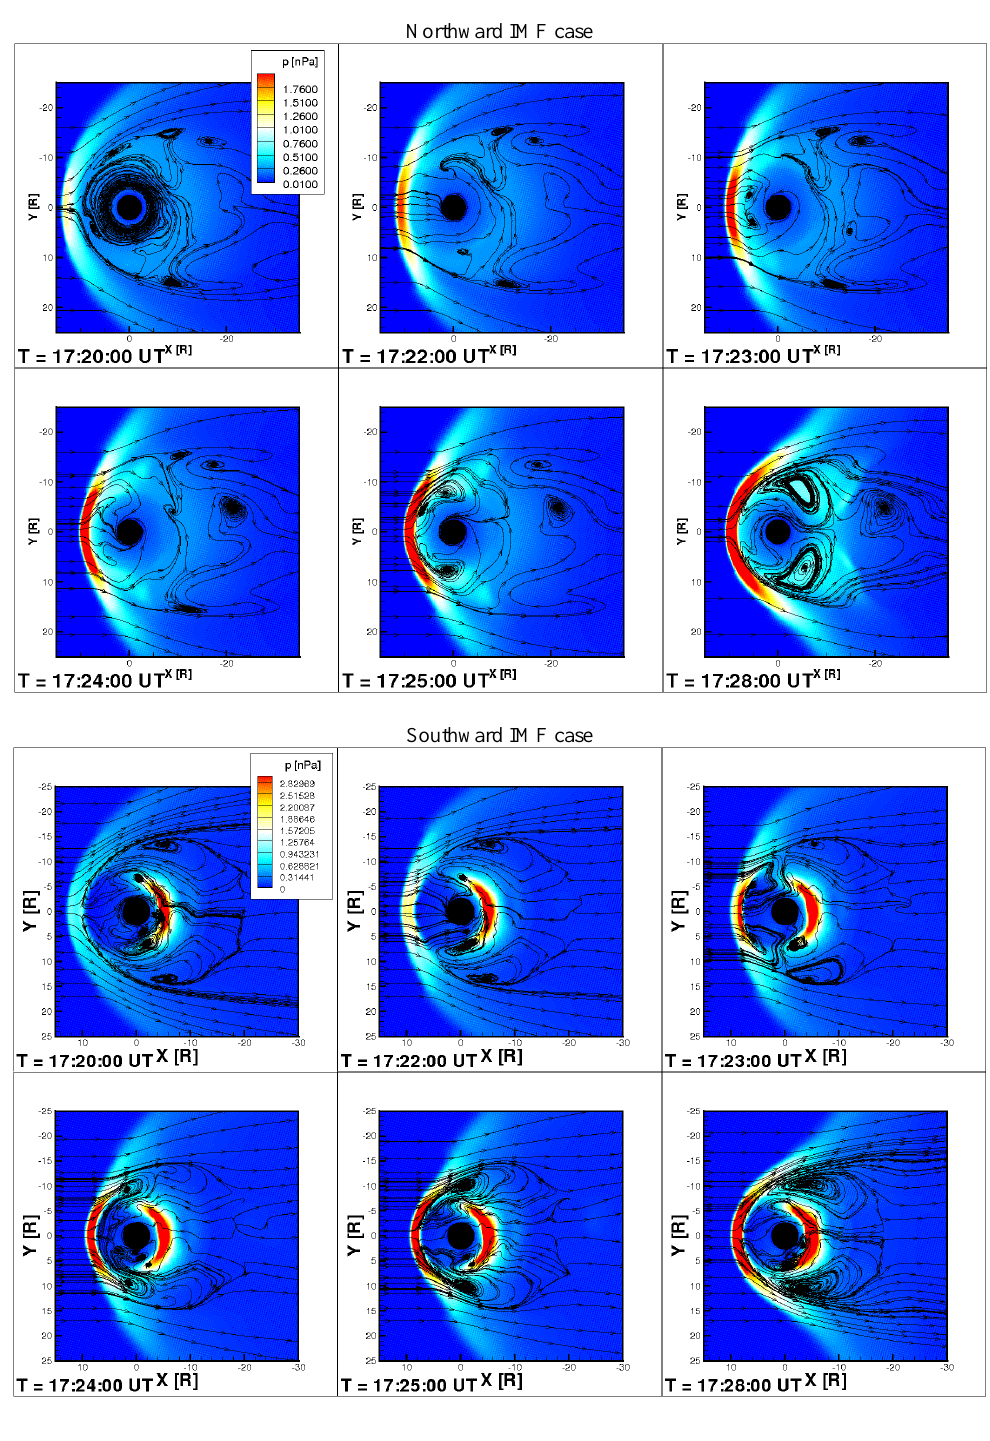
Fig. 7. Magnetospheric convections on the equatorial plane. Upper six panels: the IMF is northward; Lower six panels: the IMF is southward. The color contour represents the thermal